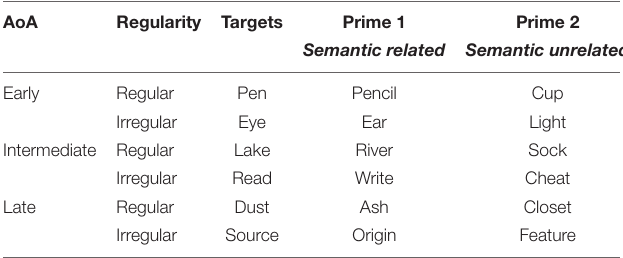
TABLE 1 | Sample of the experiment